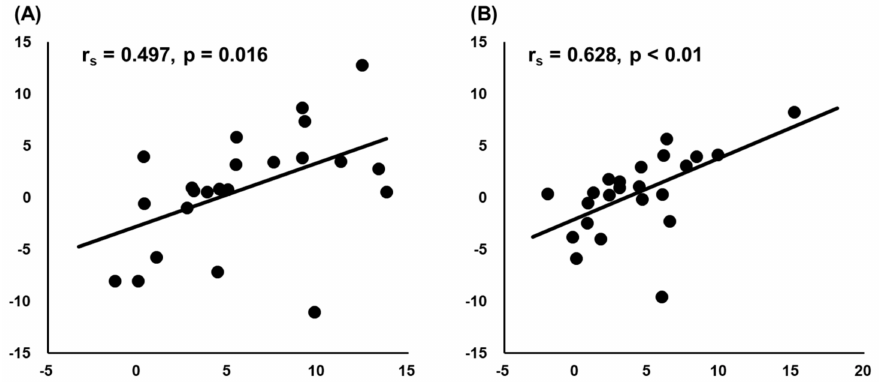
Figure 2. Relationship between change in dorsiflexion range of motion (DF ROM) and change in passive torque at DF ROM after hold–relax stretching ( A ) and static stretching ( B